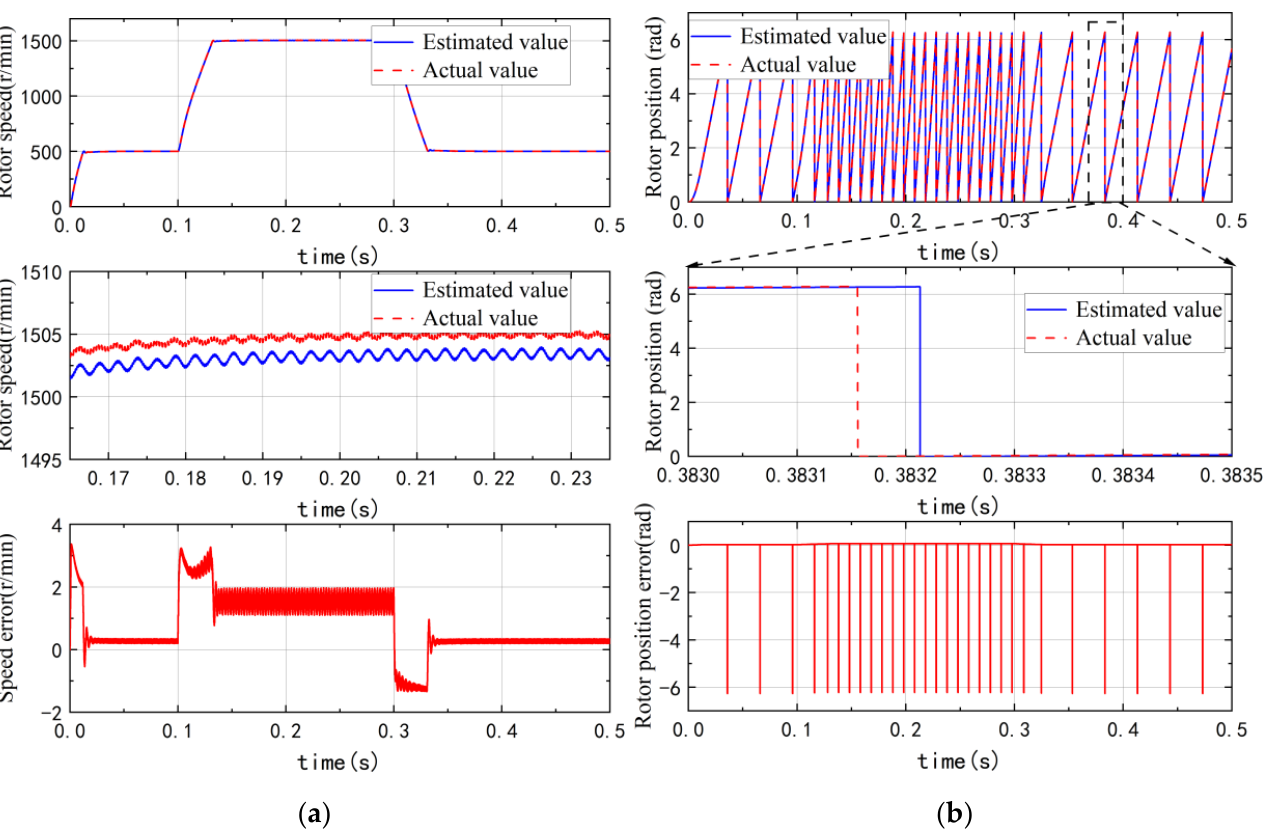
Figure 15. Speed and position estimation results of traditional SMO with LPF at variable-speed operation: ( a ) rotor speed; ( b ) rotor position.